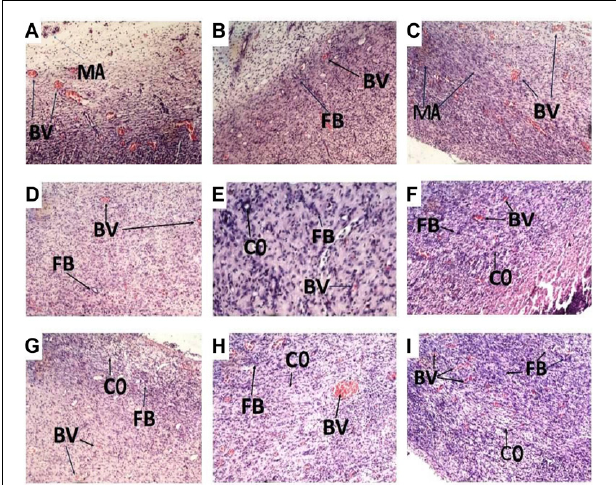
FIGURE 3 | Histological images ( × 400) representing the influence of PLE and geraniin in excised wound tissues from both treated and untreated rat wounds. Full thickness wounds were created on the dorsal region and topically treated with PLE, geraniin, silver sulphadiazine, vehicle (cream only). Wound tissues were excised 13 days post wounding and sectioned. Serial sections were stained with hematoxylin and eosin and evaluated microscopically for fibroblast proliferation, neovascularization, epithelial regeneration, and collagen deposition (H&E stain × 400). (A) Untreated wound tissues, (B) vehicle-treated (aqueous cream only) wound tissues, (C) 1% w/w silver sulphadiazine-treated wound tissues, (D) 0.25% w/w PLE-treated wound tissues, (E) 0.5% w/w PLE-treated wound tissues, (F) 1% w/w PLE-treated wound tissues, (G) 0.1% w/w geraniin-treated wounds tissues, (H) 0.2% w/w geraniin-treated wound tissues, and (I) 0.4% w/w geraniin-treated wound tissues. CO, collagen strands; MA, macrophages and monocytes; BV, blood vessels; FB,